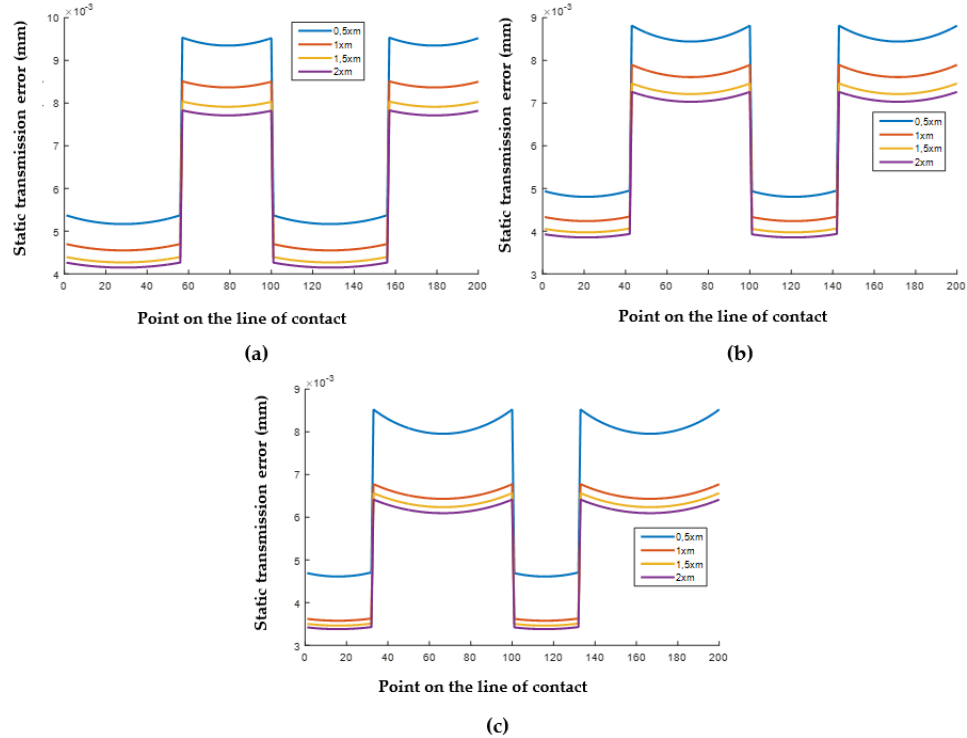
Figure 26. STE results of hybrid gears with different DSPAs: ( a ) 20°, ( b ) 25°, ( c ) 30°.